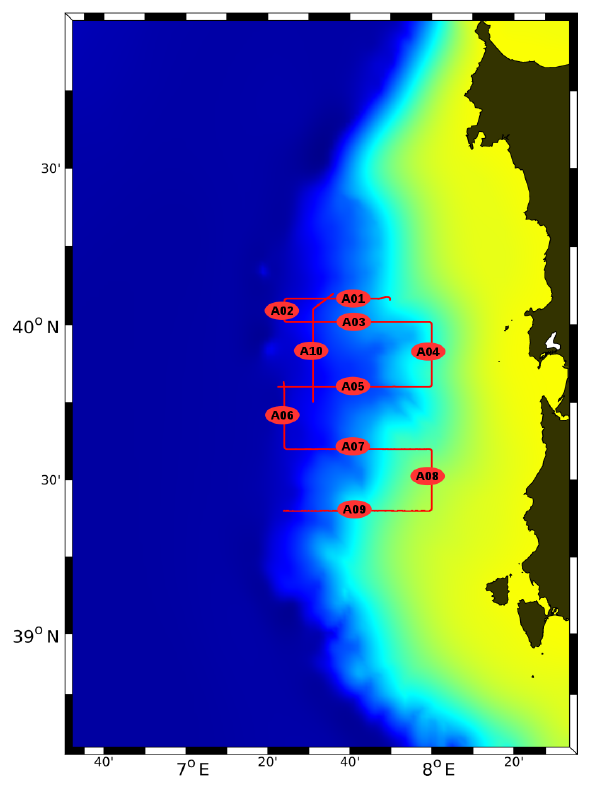
Figure 5. The ScanFish tracks of Alliance during 21–24 June. The colour code for the bathymetry is the same as in Fig.